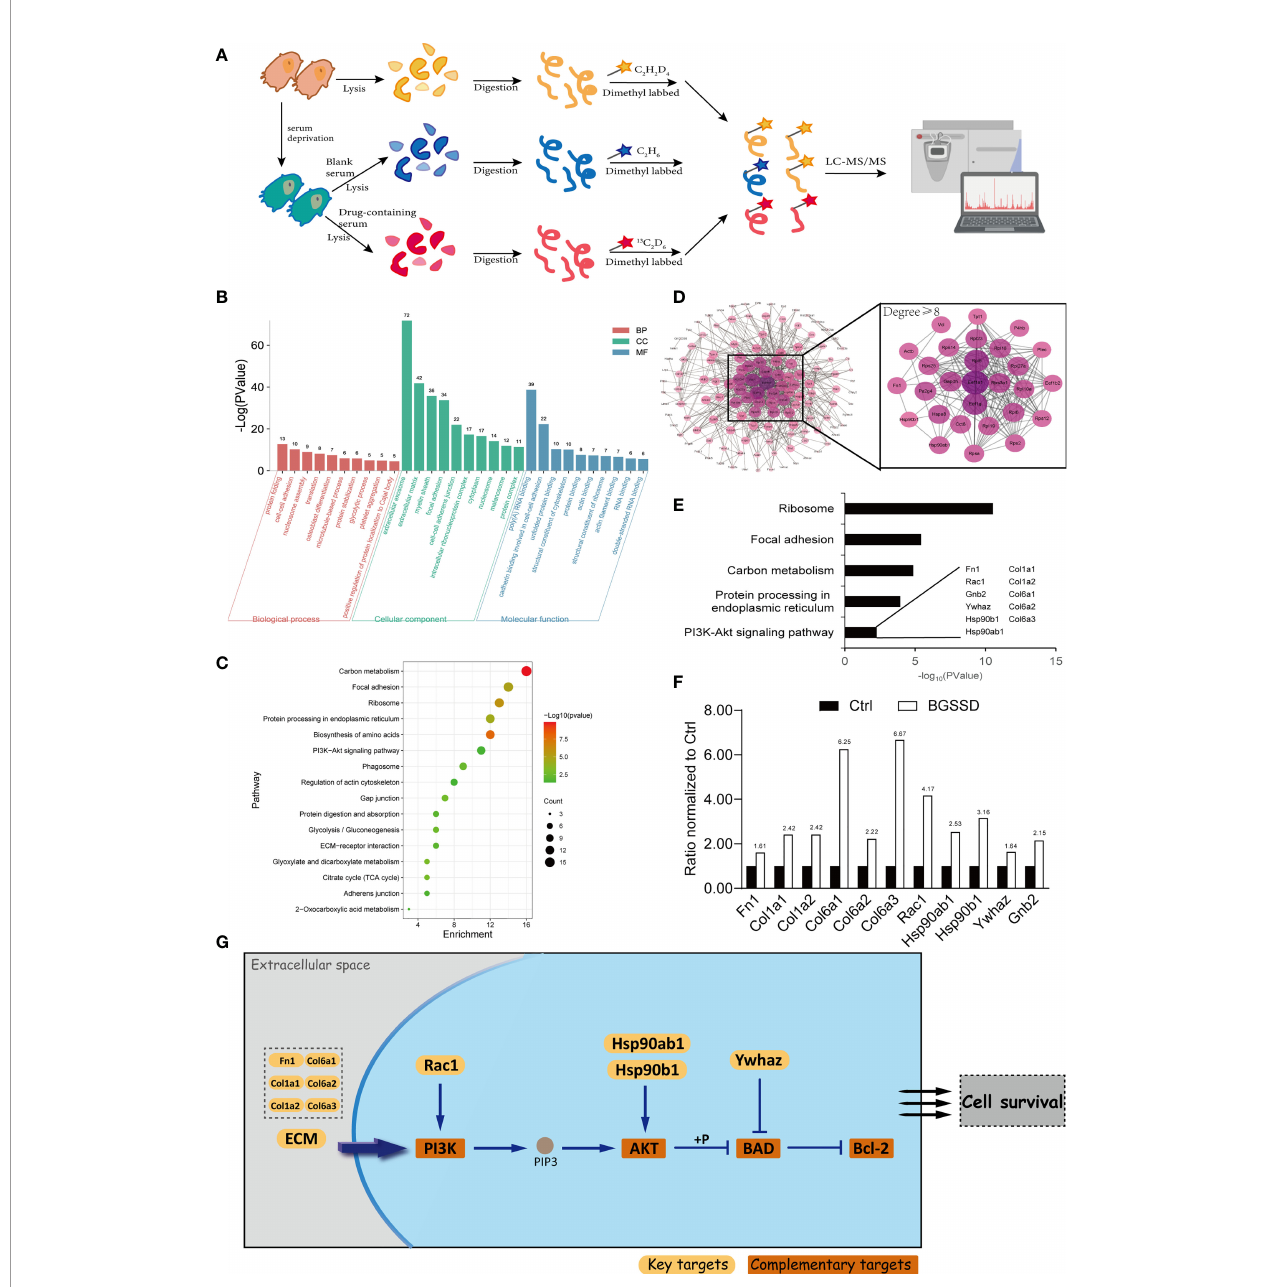
FIGURE 4 | Quantitative proteomics analysis for the pharmacodynamic network and mechanism of BGSSD. (A) Quantitative proteomics experimental scheme for detecting the differential expression of proteins. (B) Gene Ontology (GO) analysis of the upregulated targets of BGSSD, the top 10 biological processes (BP), cell component (CC), and molecular function (MF) is shown. (C) KEGG pathway analysis of the upregulated targets of BGSSD and the top 16 pathways is displayed. (D) Protein – protein interaction (PPI) networks of the upregulated targets. The proteins whose degrees are more than 8 were important and enlarged (the right part). (E) GO analysis of the important proteins identi fi ed by PPI revealed their association with the PI3K-AKT signaling pathway. The key proteins associated with the PI3K- AKT pathway were laid out. (F) The expression ratio of key proteins intervened by BGSSD compared to Ctrl. (G) The key proteins in the PI3K-AKT